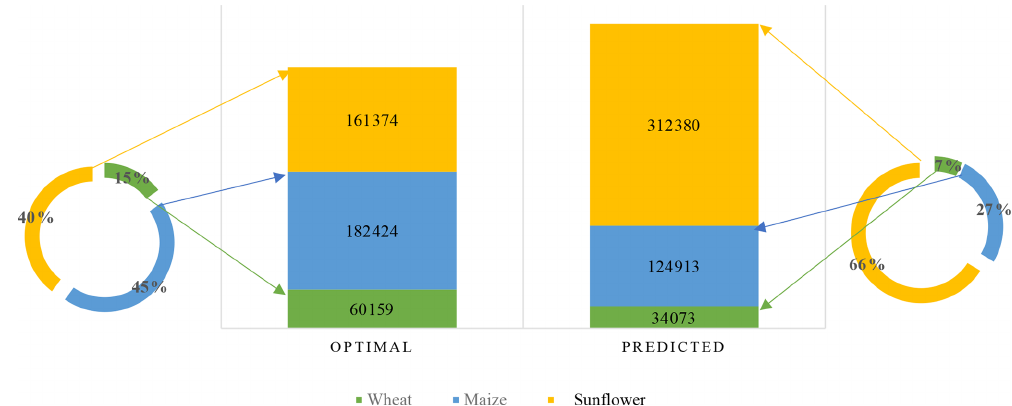
Figure 5. Predicted crop areas in the planning report compared with optimal values (hm 2 ).